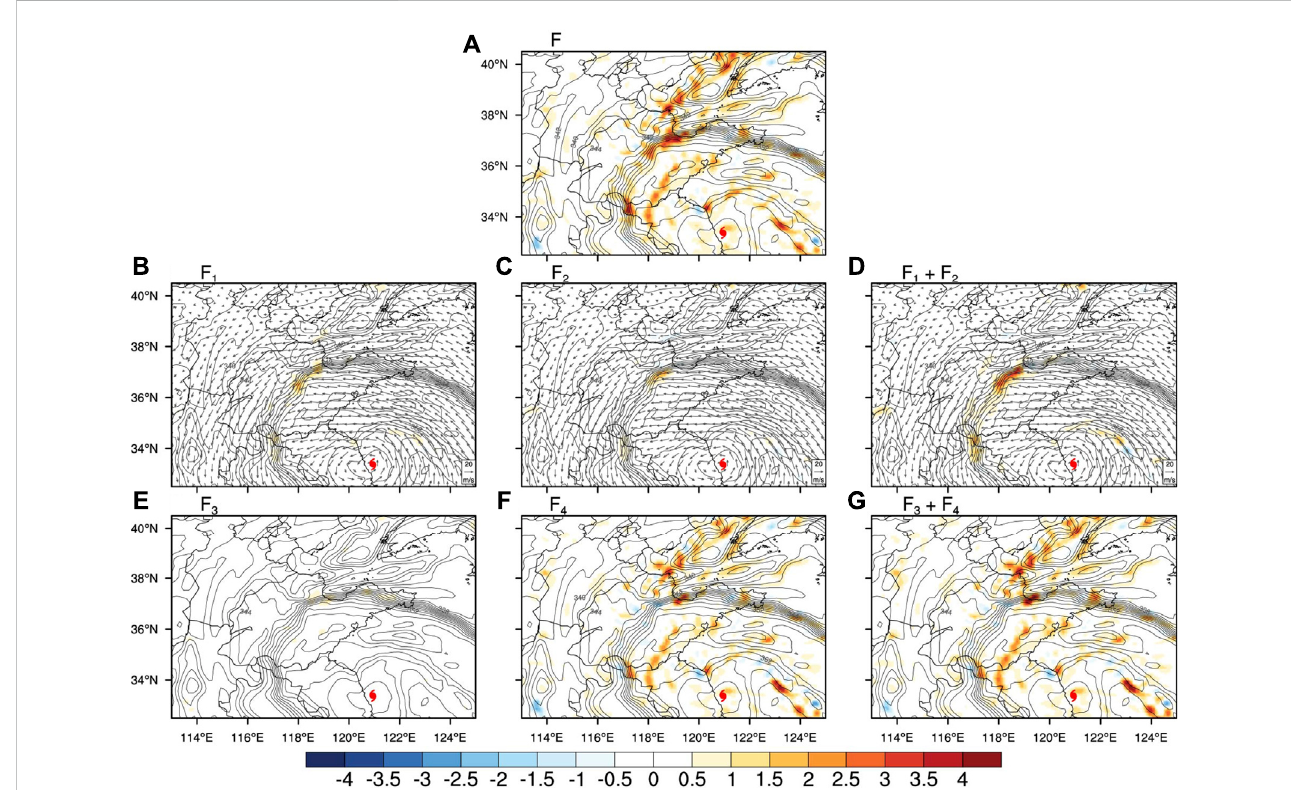
FIGURE 12 For 0300 UTC 11 August 2019, the 850-hPa equivalent potential temperature (gray contours; unit: K) with (A) frontogenesis function ( F ) (shaded; unit: 10 − 7 K/s); (B) deformation term ( F 1 ) (shaded; unit: 10 − 7 K/s), (C) divergence term ( F 2 ) (shaded; unit: 10 − 7 K/s), (D) F 1 + F 2 (shaded; unit: 10 − 7 K/s) and horizontal winds(vectors,unitvectorrepresents20 m/s); (E) tiltingterm( F 3 )(shaded;unit:10 − 7 K/s), (F) diabaticterm( F 4 )(shaded;unit:10 − 7 K/s),and (G) F 3 + F 4 (shaded; units: 10 − 7 K/s) from the D02 simulation. Typhoon symbols denote the locations of Lekima ’ s